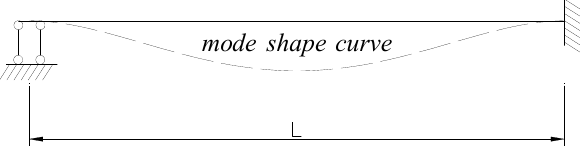
shape curvemode